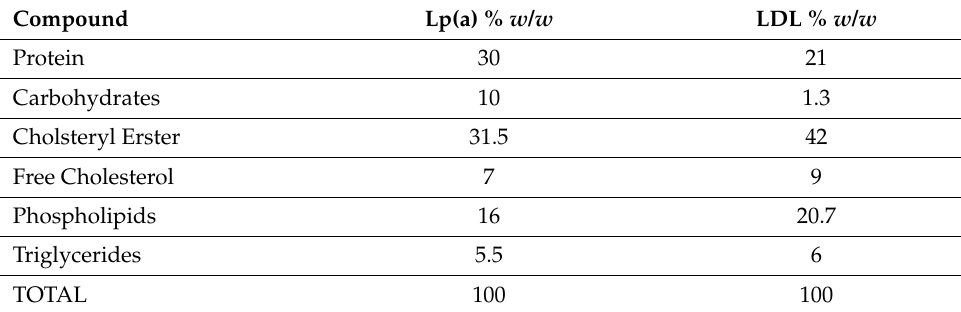
Table 1. Chemical composition of Lp(a) and LDL. Compound Lp(a) % w / w LDL % w / w Protein 30 21 Carbohydrates 10 1.3 Cholsteryl Erster 31.5 42 Free Cholesterol 7 9 Phospholipids 16 20.7 Triglycerides 5.5 6 TOTAL 100